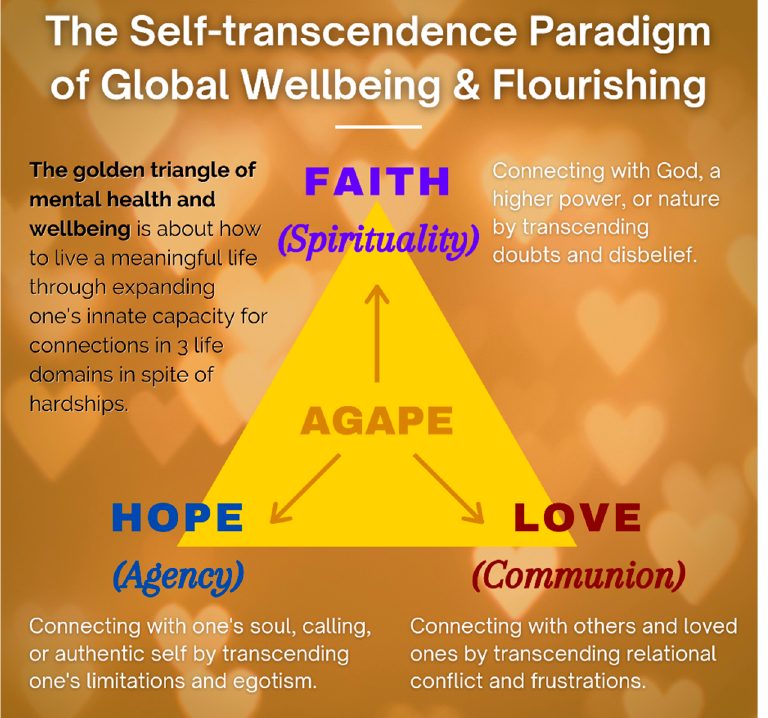
Figure 5. The Golden Triangle.